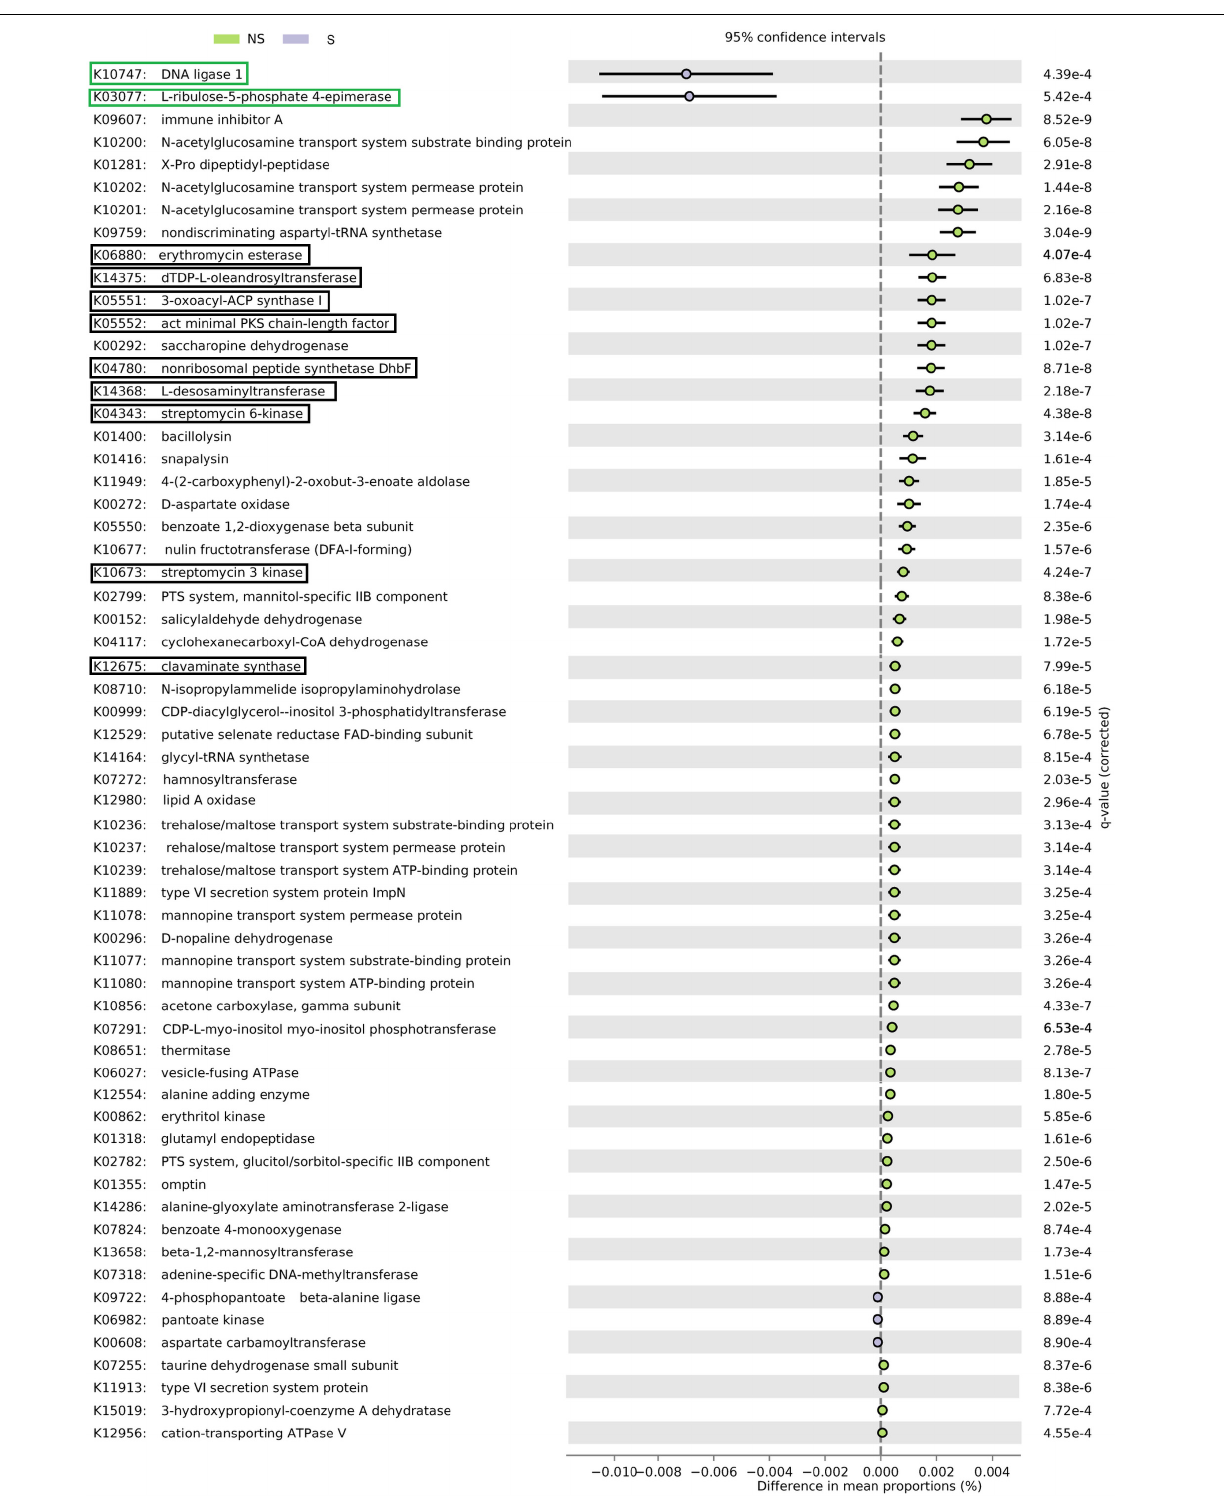
Frontiers in Microbiology |